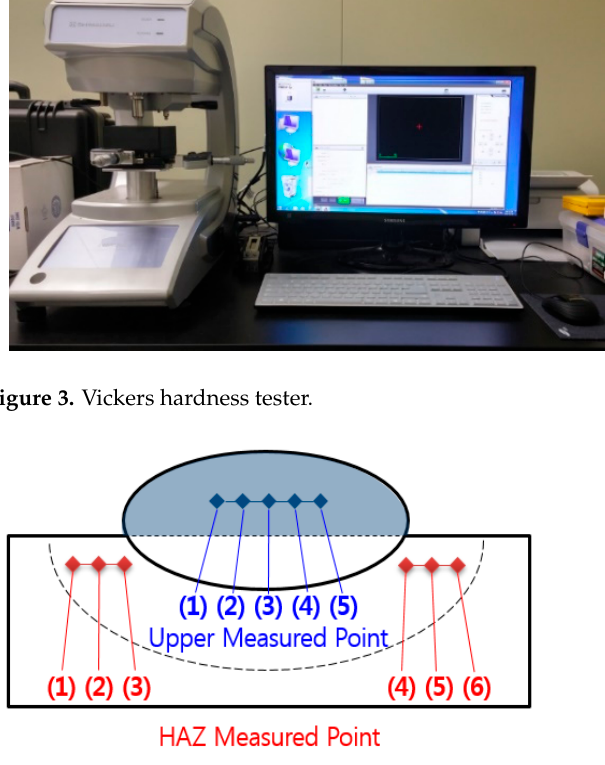
Figure 4. Measured points of the hardness test. Table 6. Hardness test results.